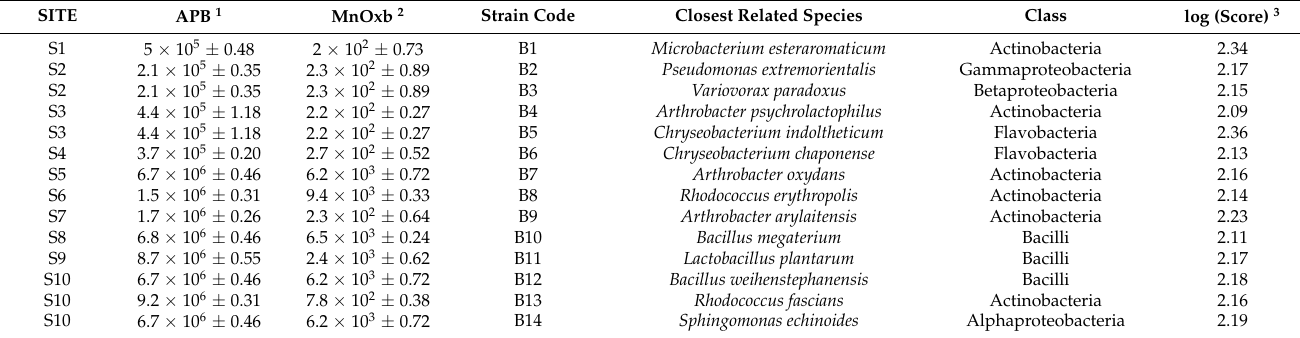
Table 1. Species detected by MALDITOF-TOF MS (BIOTYPER databank) from cultured bacteria in Mn-Ox agar.